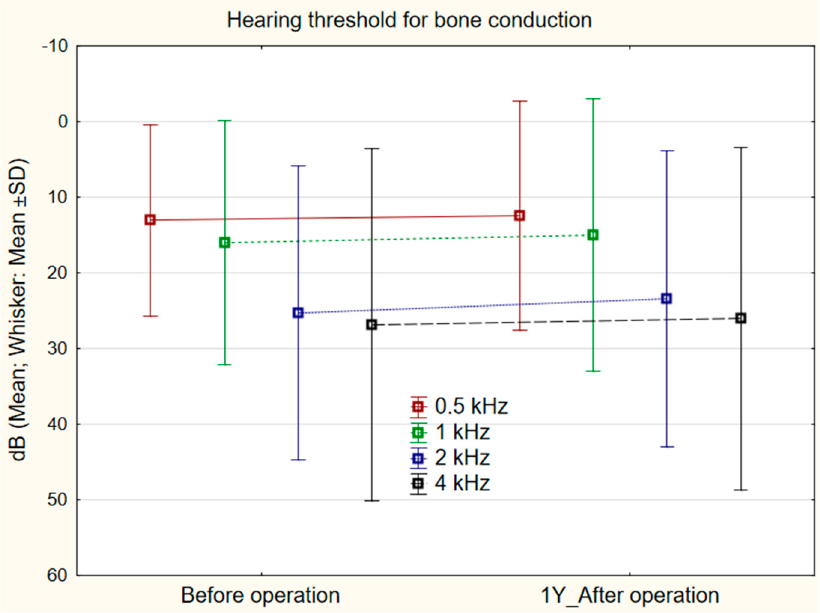
Figure 2. Hearing threshold for bone conduction (0.5, 1, 2, 4 kHz) before and 1 year after surgery ( n = 120). No statistically significant difference was found at any frequency. Mann–Whitney U Test: 0.5 kHz ( p = 0.322), 1 kHz ( p = 0.249), 2 kHz ( p = 0.265), 4 kHz ( p = 0.746).